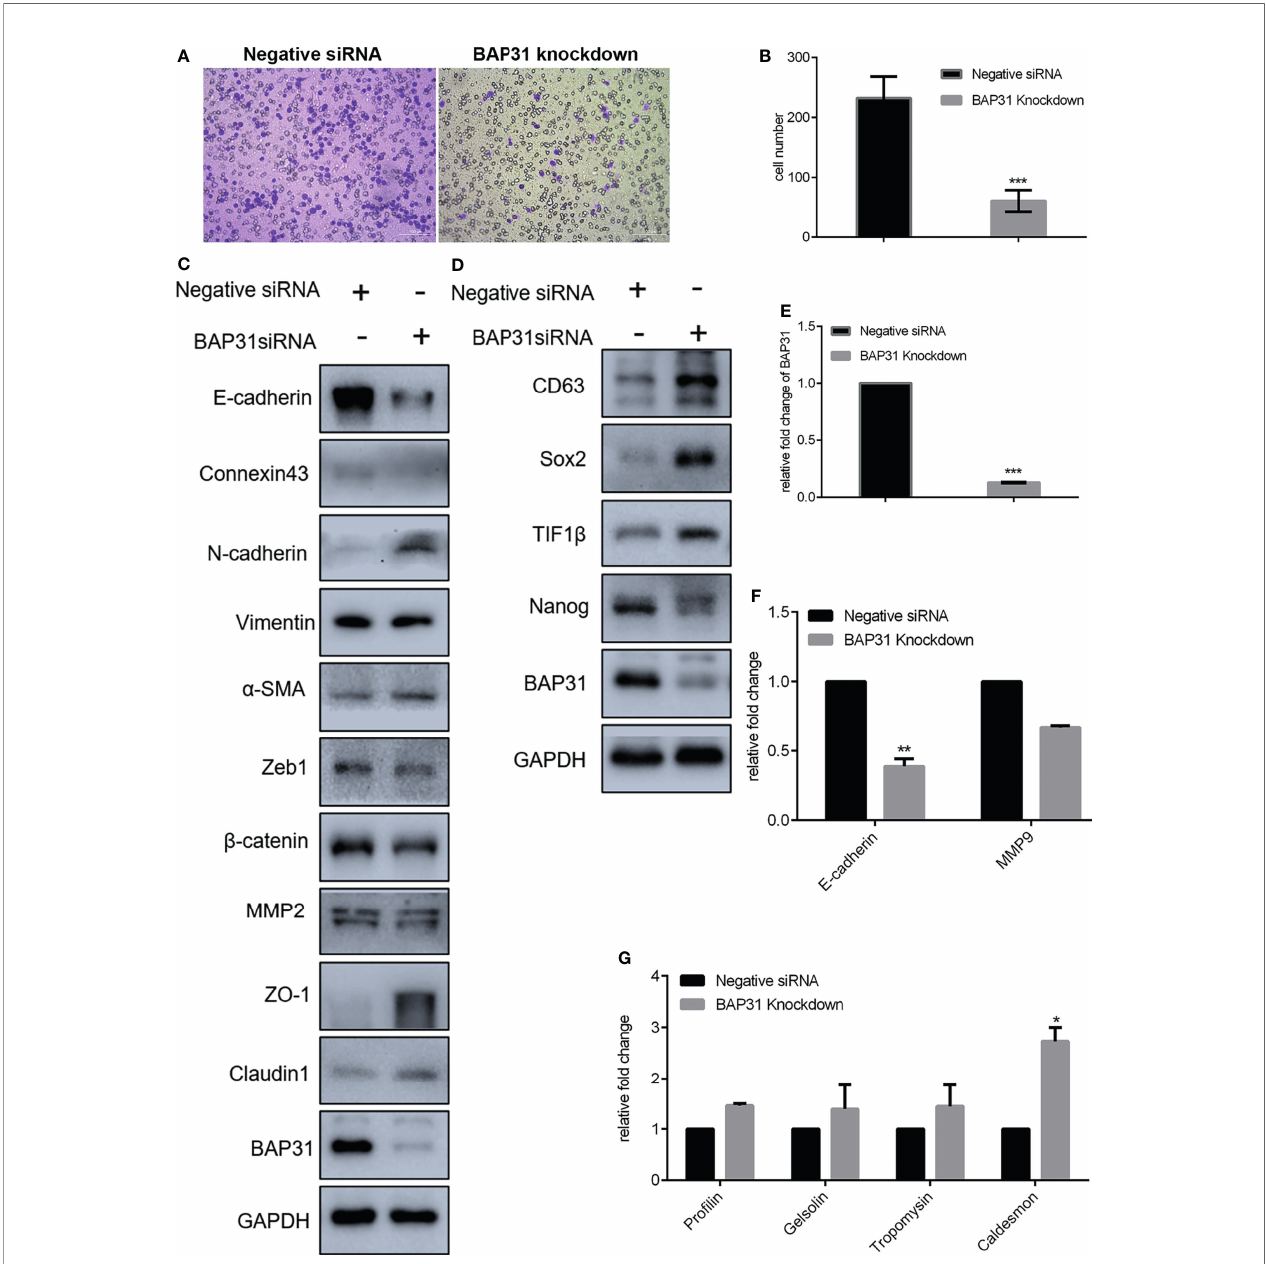
FIGURE 4 | Migration of A549 lung cancer cells that transfected with BAP31 siRNA. (A) Cell migration was evaluated by the trans-well assay. Cells that had undergone migration were stained with 0.1% crystal violet. (B) Statistics on the average migrated cell number in trans-well assay. (C, D) Protein expression as determined by Western blot analysis. (E – G) mRNA expression as examined by qPCR (mean ± SEM of duplicate experiments). * p < 0.05 versus control, ** p < 0.01 versus control and *** p < 0.001 versus